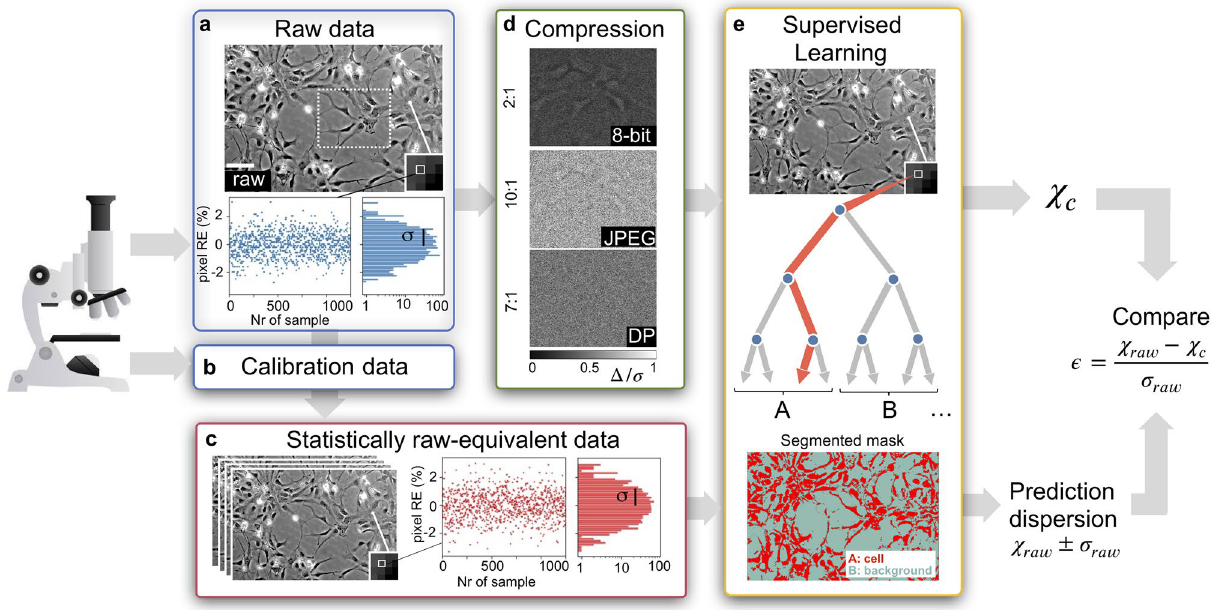
Figure 1. Quantification of the statistical distortions induced by image compression on SL predictions. ( a ) Raw imaging data from a microscope are intrinsically affected by noise: pixel values in a raw micrograph (in the figure a PC image of human neural stem cells (scale bar: 100 μm)) have a statistical distribution of width σ and mean μ. This distribution can be reconstructed by plotting the single pixel relative error (RE) from 1000 acquired images at the same light intensity (left inset: RE as a function of the number of images or samples; right inset: histogram of the RE values). ( b,c ) Via calibration data of the acquisition sensor, statistically raw-equivalent unprocessed images (with same σ and μ) are generated. ( d ) Image compression is performed on raw data: the differences between the 8-bit, 10:1 JPEG, 7:1 DP compressed formats and the raw image (∆), normalized to the per-pixel noise σ(∆/σ), indicate the artifacts induced by compression on the original image. The displayed image portions correspond to the dotted rectangle in ( a ). ( e ) A SL model, trained on raw data, is used to classify single pixels into two classes A and B. In this work, a Random Forest algorithm classifies pixels according to cell (A) and background (B) classes and produces cell segmentation masks. The model is tested on the statistically raw- equivalent synthetic data to determine the standard deviation σ raw associated to a certain parameter χ raw . The model also predicts a value of the considered parameter from the compressed data χ c . To verify the statistical impact of image compression, the value of χ c is compared to χ raw via the standard score ǫ = χ raw − χ c σ SL predictions on the compressed image exceed the statistical variability stemming from raw data noise. The figure has been generated via Python 3.7.3, the Trainable Weka Segmentation plugin (v3.3.1) in ImageJ 2.3.0/1.53f., and Microsoft PowerPoint